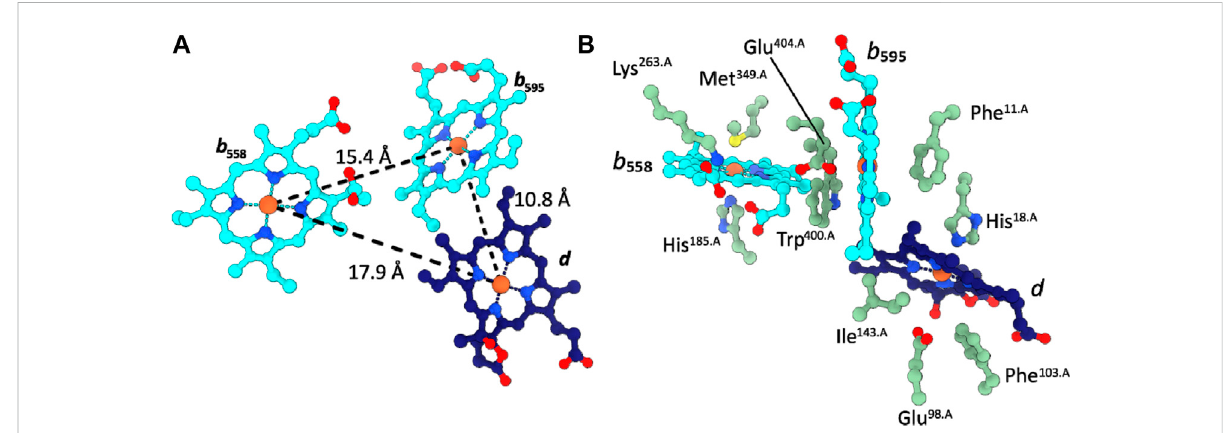
FIGURE 2 Cofactor arrangement in Cgbd . (A) Triangular heme arrangement in CydA. (B) Axial ligands and proximal side chains of the prosthetic heme groups in Cgbd . Color code: CydA, green; b -type hemes, cyan; heme d , dark